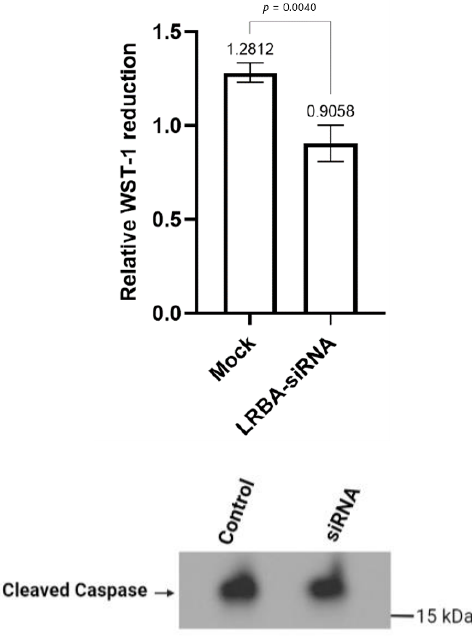
Figure 6. Cell viability assay in LRBA-knockdown MIN6 cells displayed a 30% reduction in cell metabolism. Cleaved-caspase-3 protein ( ≈ 17 kDa) expression was similar in control and LRBA-knockdown MIN6 cells. Error bars represent SD, the experiment was repeated three times independently with three replicates. Paired parametric t test was used.